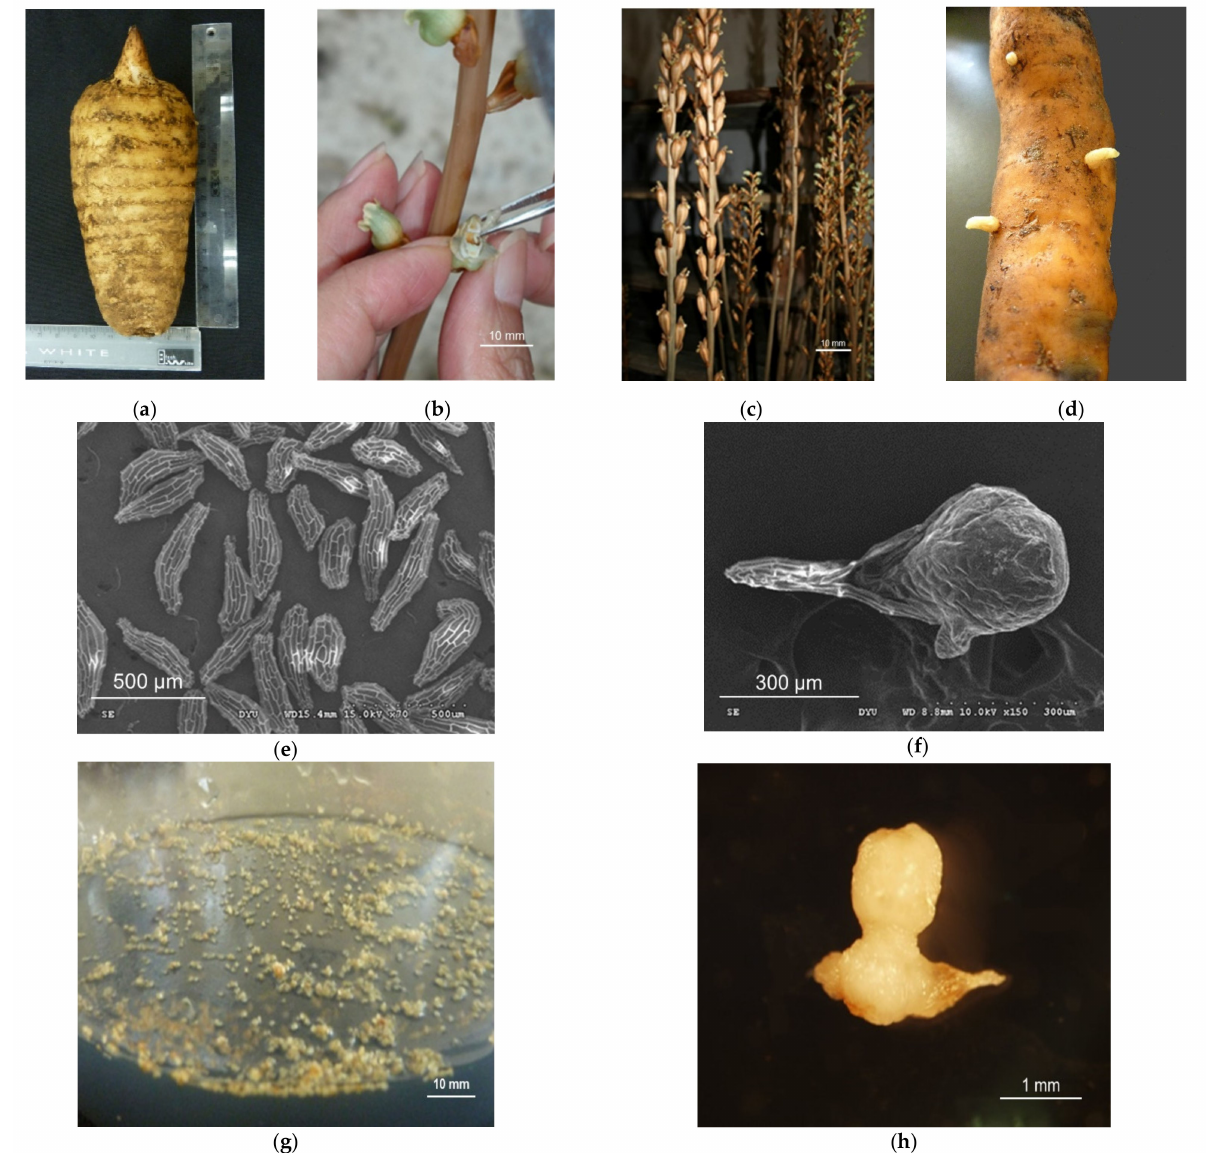
Figure 1. The rhizomes, flowers, pollination, capsules and seed germination of G. elata . ( a ) Mature rhizome bearing a dormant inflorescence in bud which was a typical commercial product; ( b ) hand pollination; ( c ) capsules on the flower stalk; ( d ) immature rhizome having buds breaking dormancy; ( e ) seeds under SEM; ( f ) seeds germinating in vitro bursting the seed coat under SEM; ( g ) seed germination on culture medium; ( h ) a germinated seed grow into a protocorm with seed coat still attached beneath, under a stereo